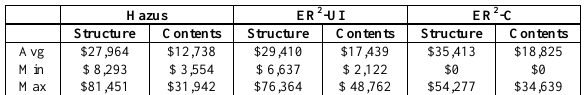
Table 2. One-story single family residences, statistics from 156 buildings in Fredericton, NB Estimates from 2008 flood